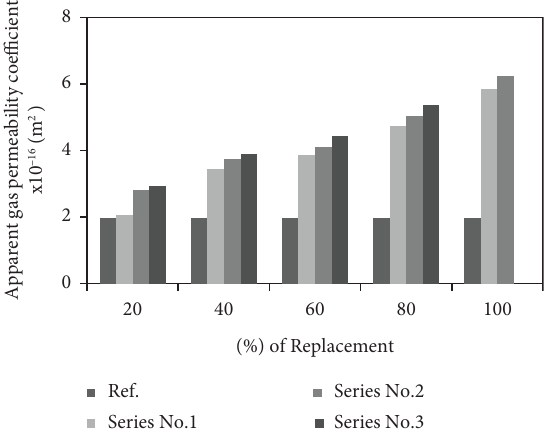
Figure 10: Gas permeability variations of